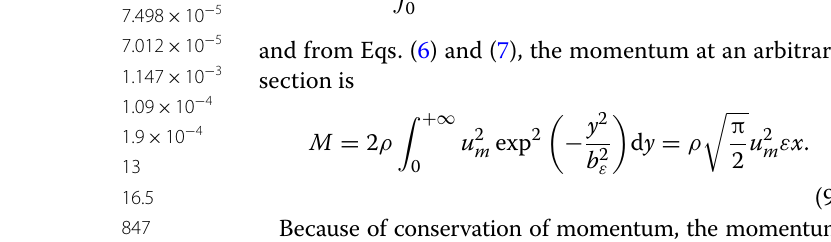
Table 1 Values of the DJV parameters